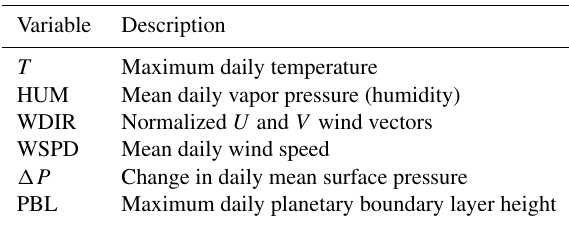
Table 2. Meteorological variables